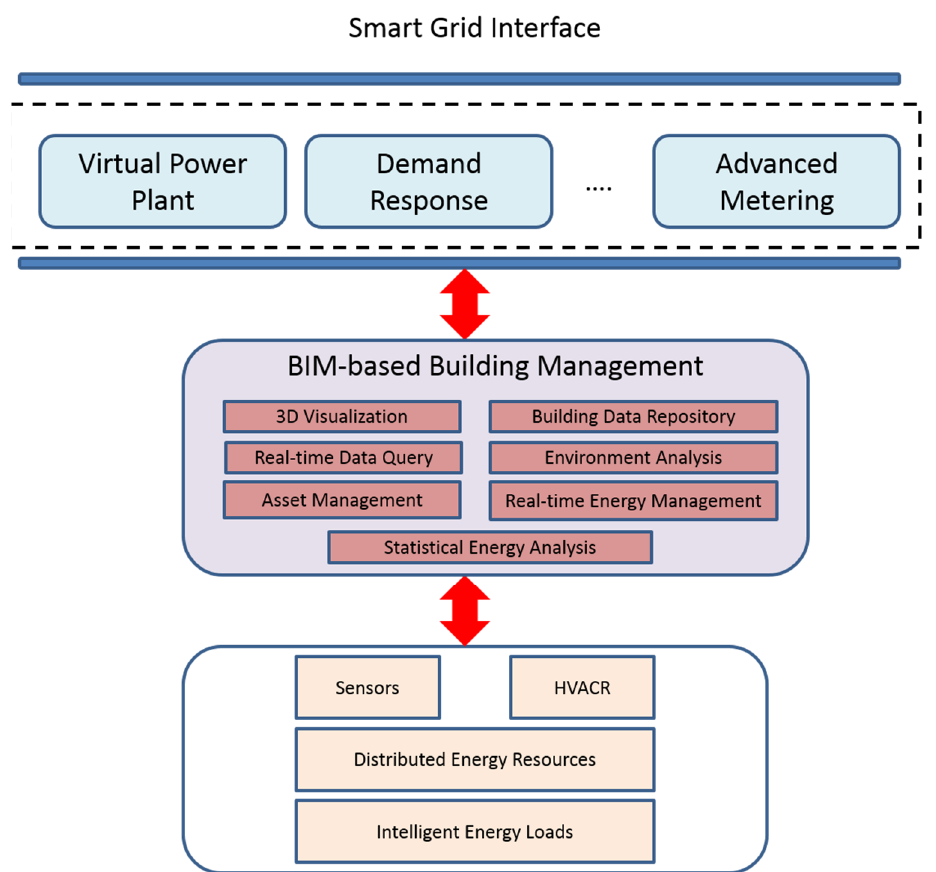
Figure 12. Proposed BIM-based building management for a smart